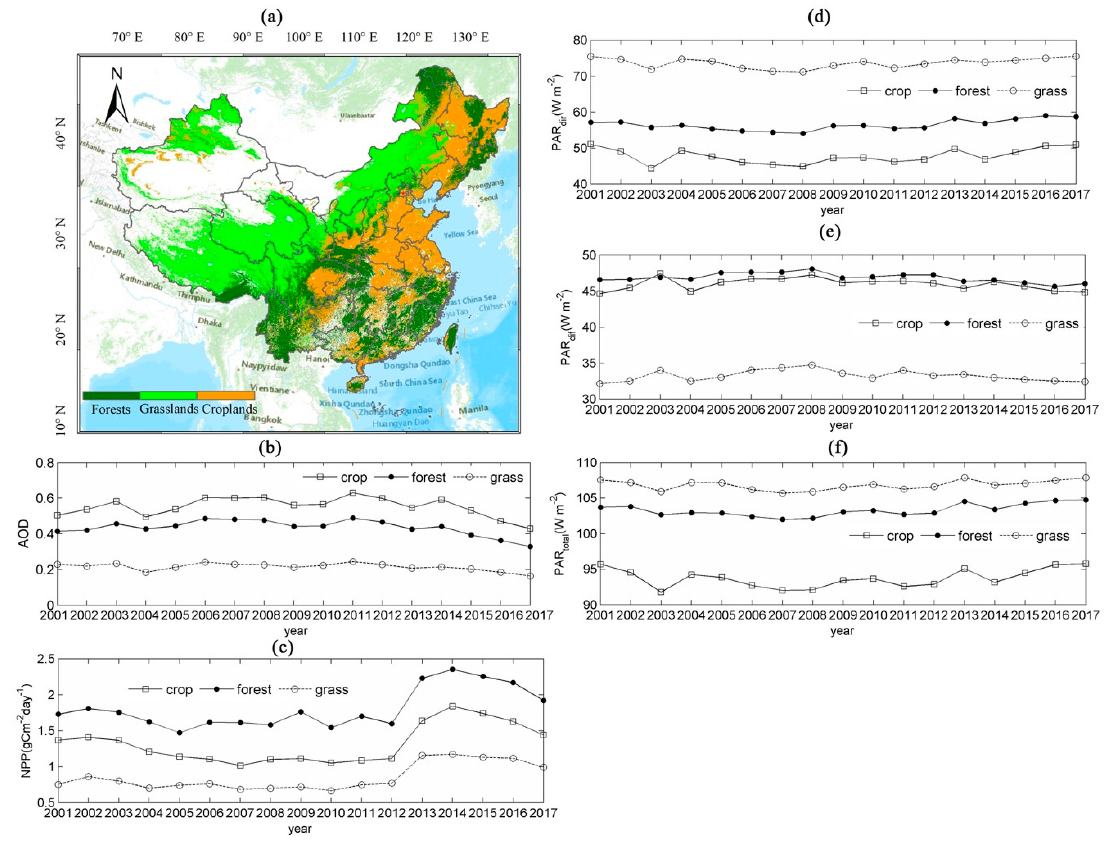
Figure 8. The distribution of croplands, grasslands and forests in 2013 ( a ) and yearly mean AOD ( b ), NPP ( c ), PAR dir ( d ), PAR dif ( e ) and PAR total ( f ) for three vegetation covers.